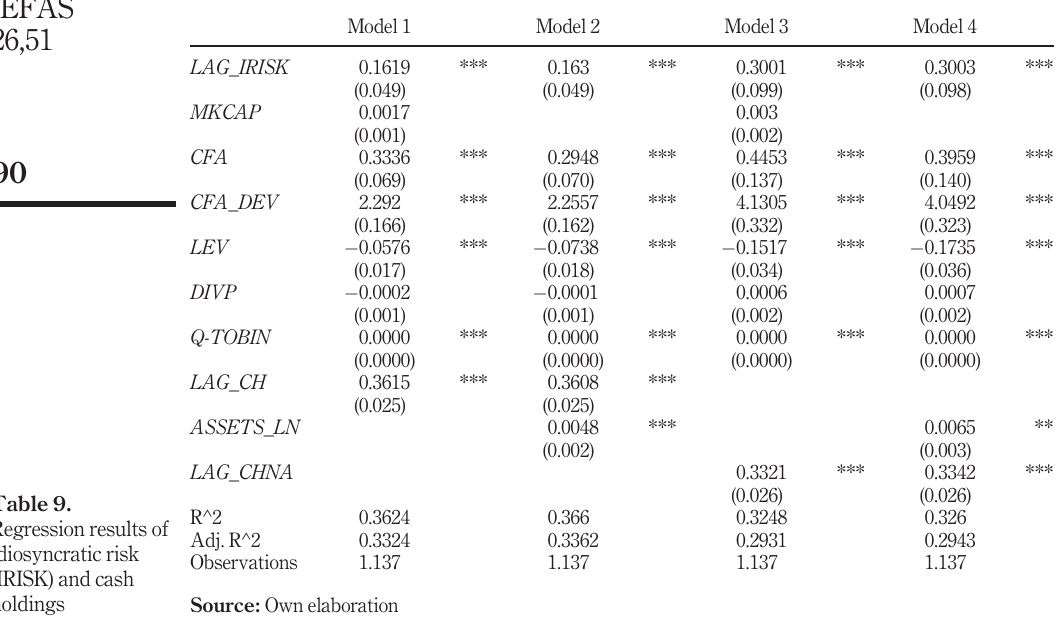
Table 9. Regression results of idiosyncratic risk (IRISK) and cash